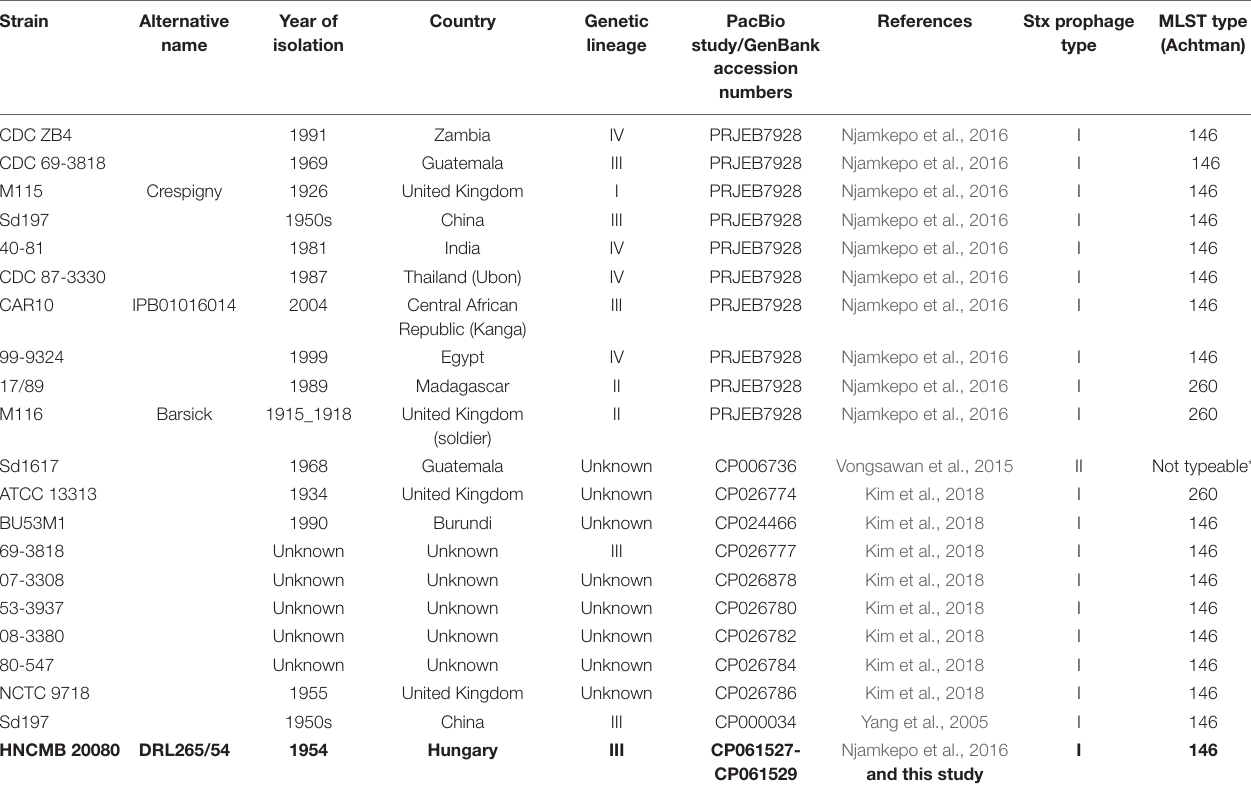
TABLE 1 | List of complete SD1 genomes available in GenBank as well as draft genomes determined by PacBio sequencing used in this study.